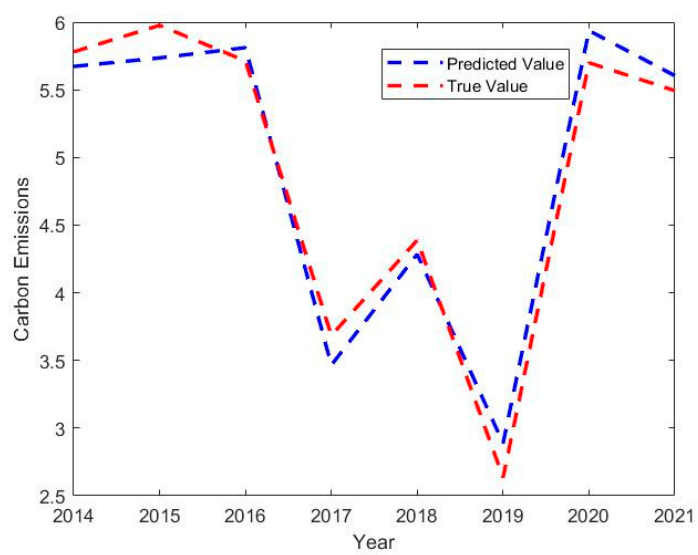
Figure 6. Model prediction results.